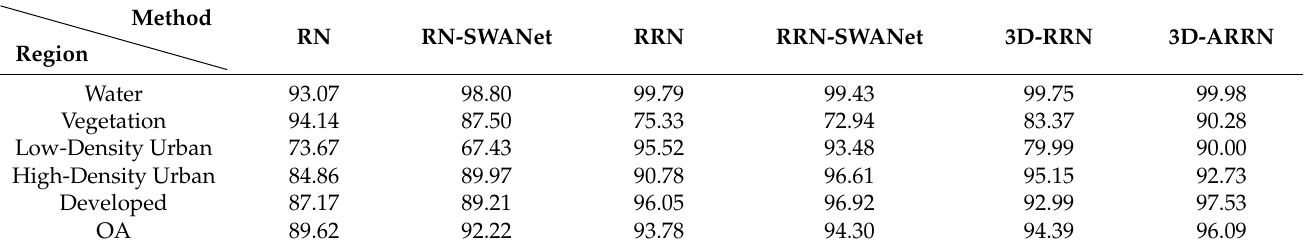
Table 5. The classification accuracy of all methods with 7 labeled samples per class on the San Francisco dataset.